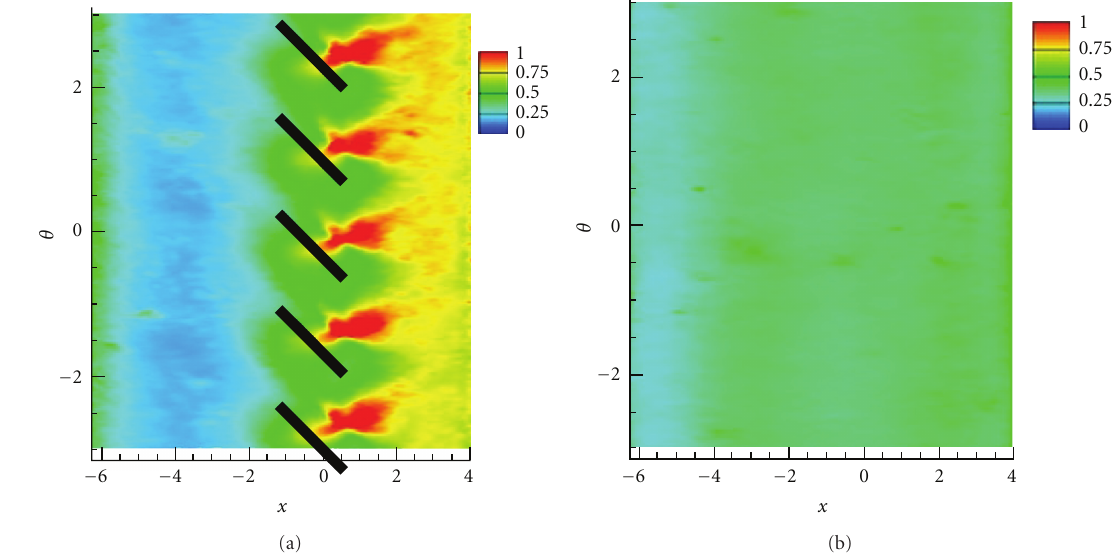
Figure 14: Pressure distributions on the duct surface: (a) σ ( p ) on inner surface, (b) σ ( p ) on outer surface.